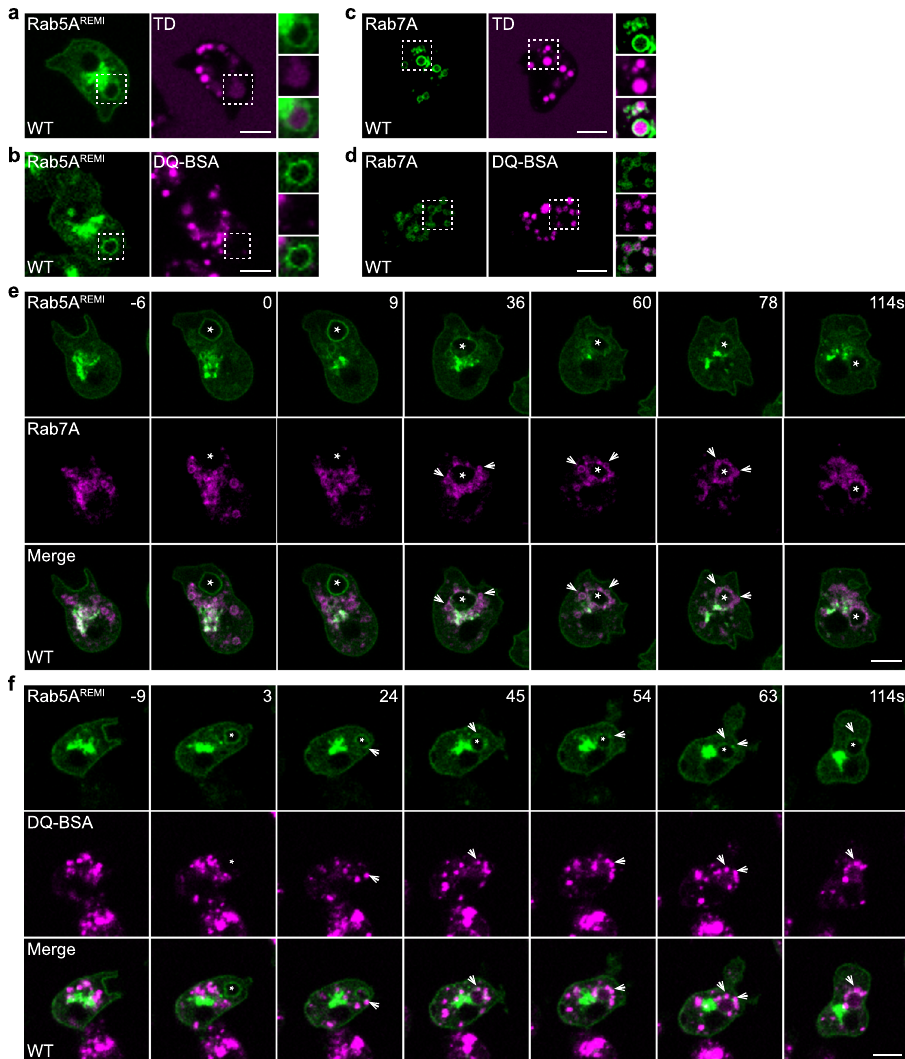
Fig. 1 Vesicle fusion mediates Rab5-to-Rab7 conversion during macropinosome maturation. a – d The uptake of TRITC-dextran (TD) or DQ-BSA in WT cells expressing GFP-Rab5A REMI or GFP-Rab7A. Images were acquired after a 60-min incubation. Magni fi ed images of the areas indicated by dashed boxes are shown at the right. e Time-lapse images of macropinocytosis in WT cells expressing GFP-Rab5A REMI and RFP-Rab7A. The asterisks mark a newly formed macropinosome initially decorated by GFP-Rab5A REMI . The arrows mark RFP-Rab7A-labeled late macropinosomes that surrounded and fused with the newly formed macropinosome. The time of macropinocytic cup closure is de fi ned as “ 0 s ” . f Time-lapse images of GFP-Rab5A REMI /WT cells pre-incubated with DQ-BSA for 60 min. Images were acquired after DQ-BSA was washed out. The arrows mark preformed macropinosomes containing bright DQ-BSA signal. The asterisk marks a newly generated macropinosome, which gradually obtained DQ-BSA signal through vesicle fusion. Scale bar = 5 μ